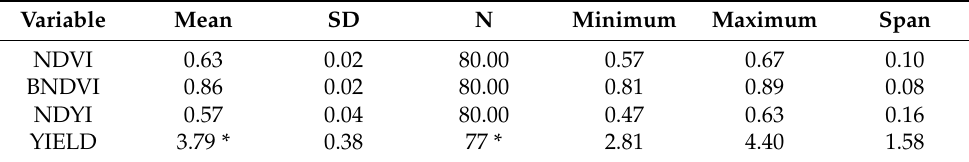
Table 3. Results of the statistical analysis of vegetation indices and yield.